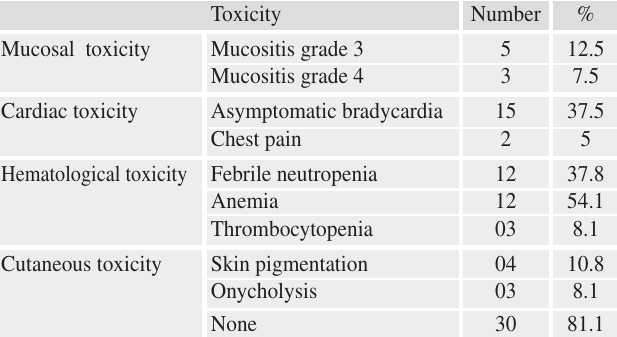
Table II: Toxicity with the treatment schedule (cid:13)